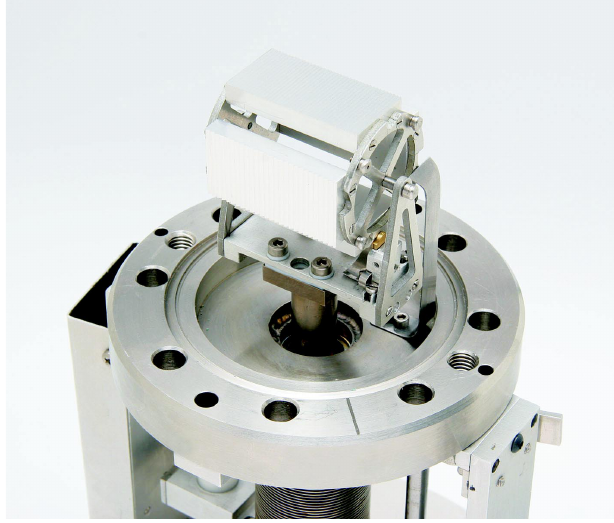
FIG. 3. (Color) The carousel mechanism carrying three gratings and the blank.